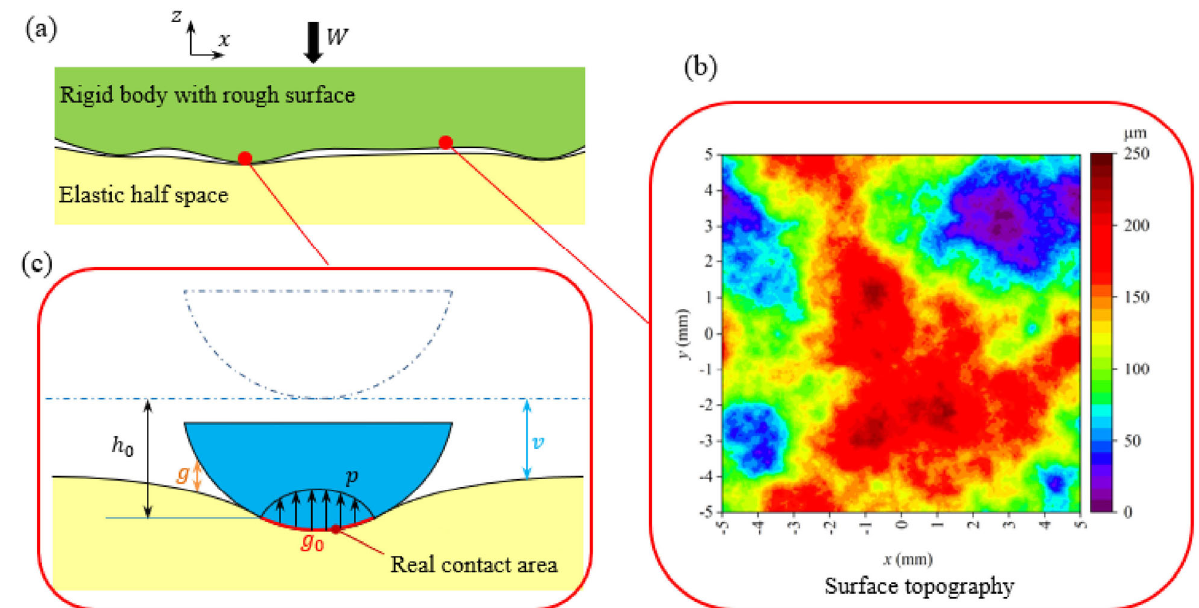
Fig. 1 The contact of the rigid rough body and an elastic half-space. (a) Macroscale contact configuration, (b) surface topography of the rigid body, and (c) asperity-scale deformation